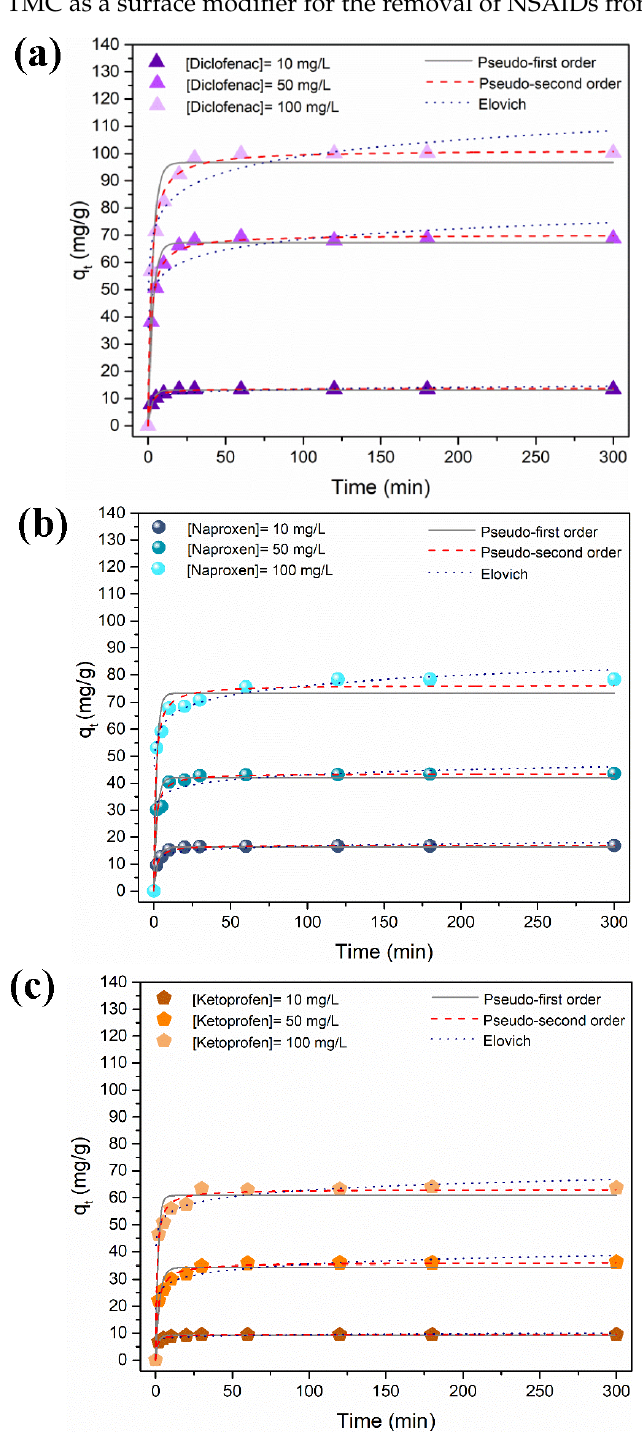
Figure 5. Time profile of adsorption capacity of ( a ) diclofenac, ( b ) naproxen, and ( c ) ketoprofen using the Fe 3 O 4 @SiO 2 /TMC/GPTMS particles at variable initial concentrations (10, 50, and 100 mg/L, at pH = 5, contact time of 300 min/5 h) and the corresponding kinetic model fitting. Overall, the pseudo-second-order equation provided good fits for all the NSAIDs (R 2 between 0.98 and 0.99 and low χ 2 value), supporting the chemisorption mechanism. More- over, the values of q t obtained from the pseudo-second-order model were closer to the experimental results than the qt values predicted from the pseudo-first-order and Elovich